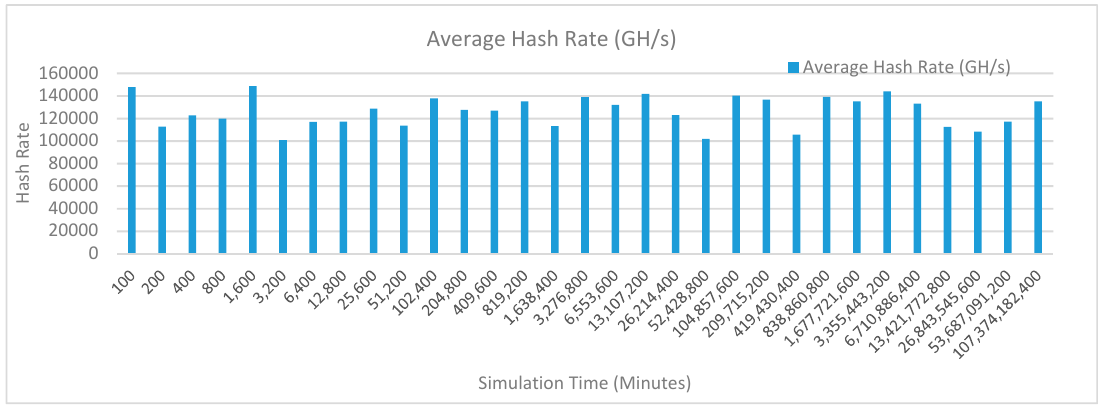
Figure 14. Average hash rate analysis (with IoT, edge, fog, and cloud).